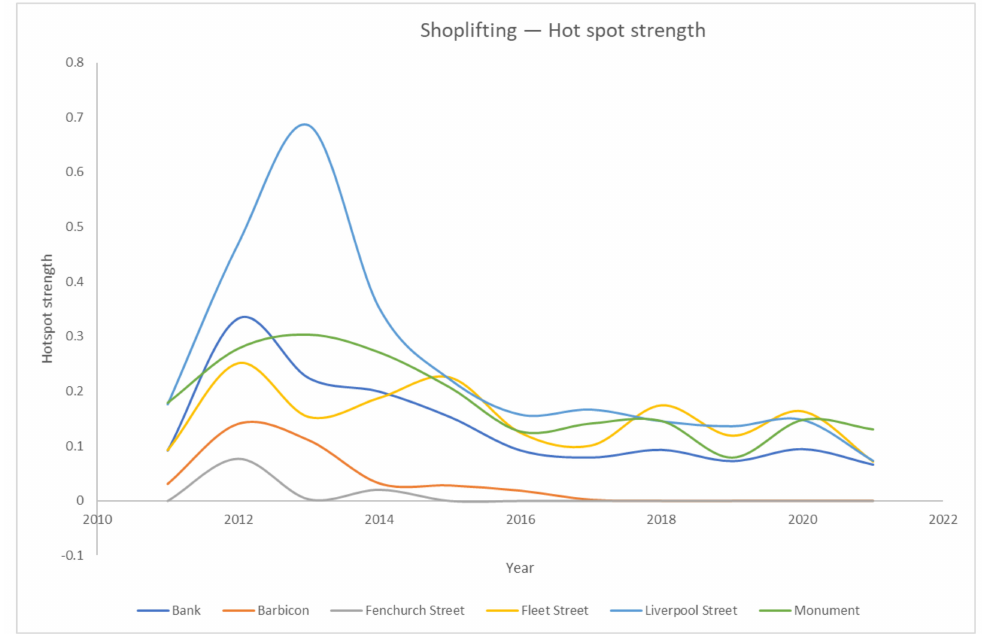
Figure 20. Trends of the hot spot strengths for shoplifting in all the six clusters of the City of